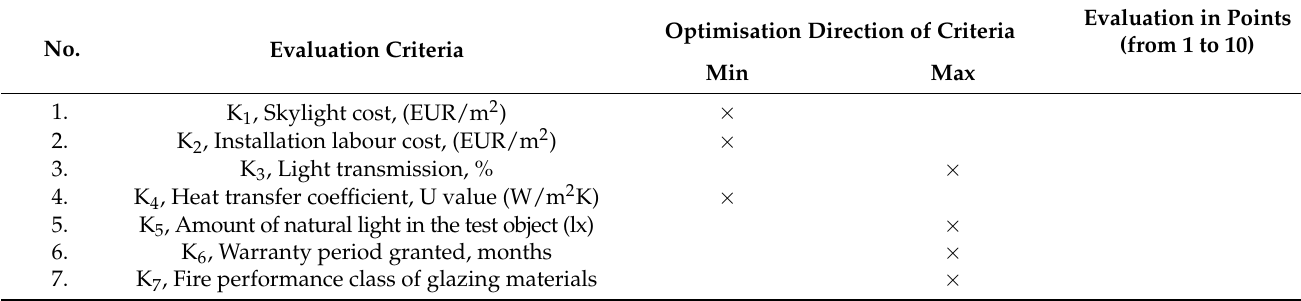
Table 4. Initial information for interviewees presented in the